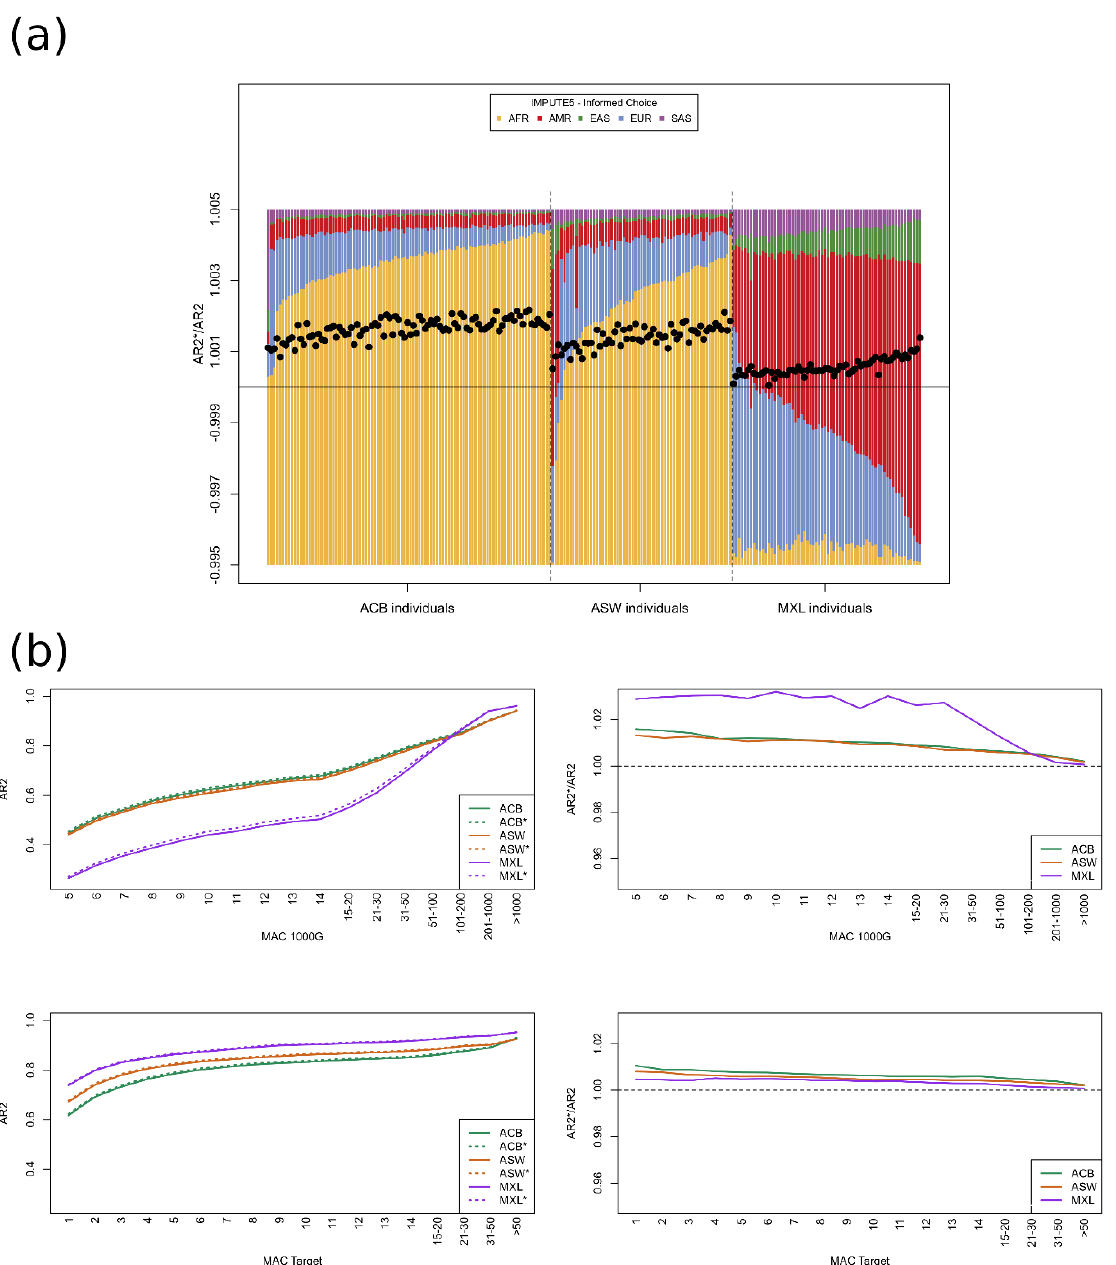
Figure 4. Similar to Figure 3, here, we compare the ‘informed choice’ strategy with the base line imputation. ( a ) The proportions plot corresponds to the cumulative proportions across imputation barcodes under the ‘informed choice’ strategy. The points overlaid correspond to individual AR2*/AR2 statistics as in Figure 3, but the AR2* now comes from the ‘informed choice’ strategy. ( b ) As Figure 3b but again the AR2* statistics come from the ‘informed choice’ strategy.